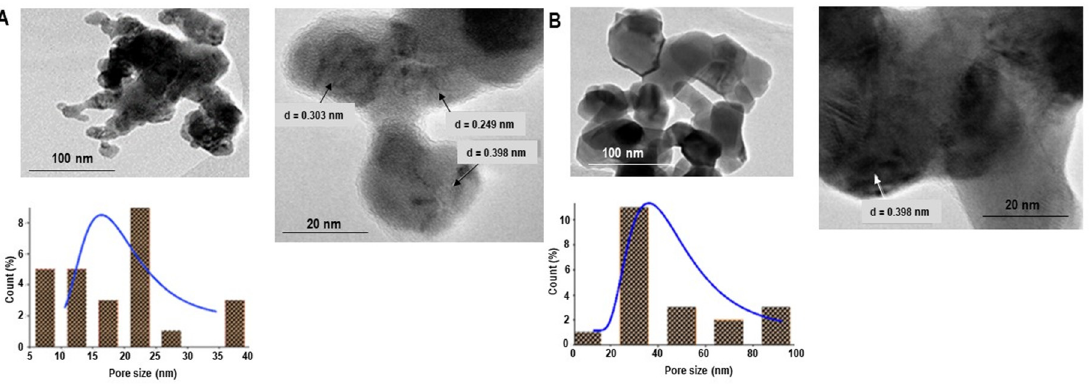
Figure 7. TEM images and particle size histograms of LaMnO 3 calcined at ( A ) 700 °C and ( B ) 900